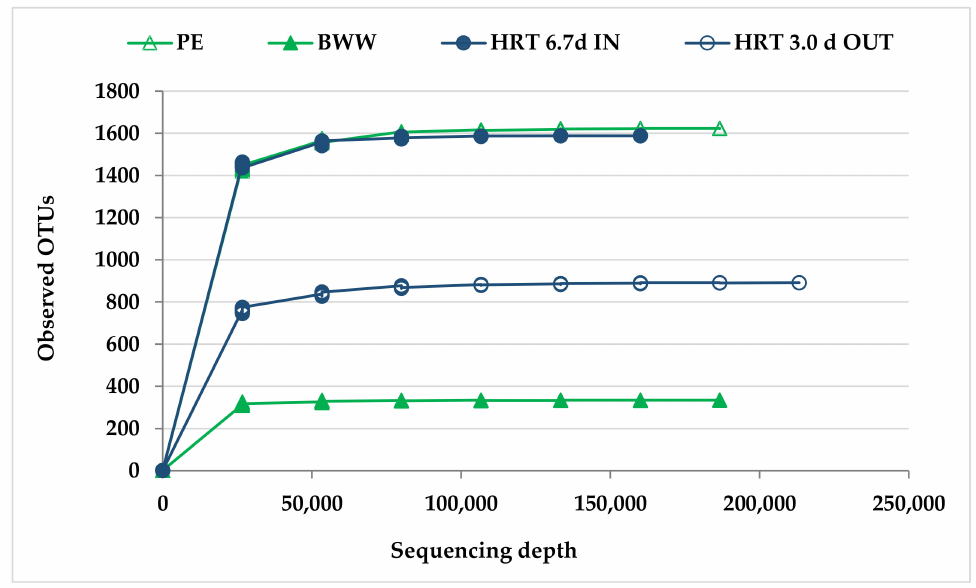
Figure 4. Alpha rarefaction curves for the occurrence with which OTUs were detected at each sample from effluents and from hybrid anaerobic reactor. PE—piggery effluent; BWW—brewery wastewater; HRT—hydraulic retention time; OUT—operational taxonomic unit.